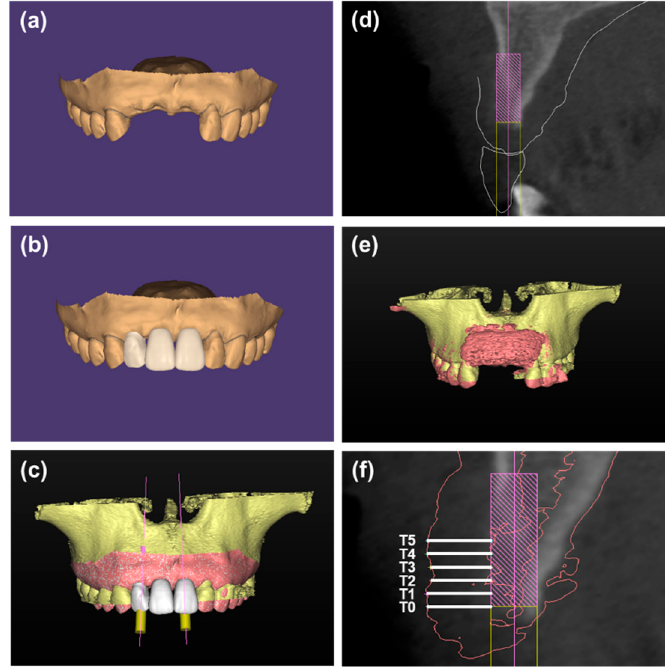
Figure 5. ( a – d ) Virtual implants were placed in a prosthetically ideal position under the guidance of the diagnostic wax-up. ( e ) The DICOM files of the postoperative CBCT were converted to STL files (red) and superimposed on the preoperative CBCT (yellow). ( f ) The thickness of labial bone graft was measured from the labial outline of the bone graft (red lines) to the implant (T0–T5).